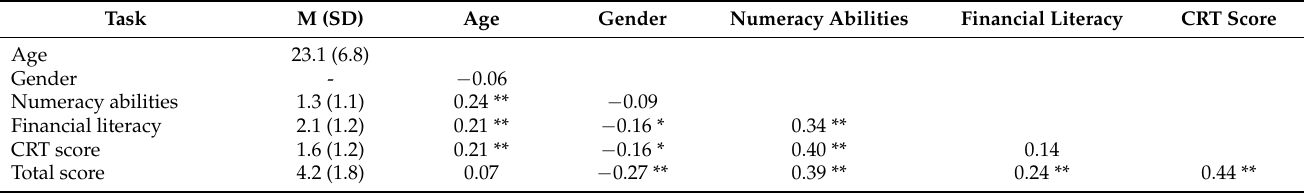
Table 5. Descriptive statistics and